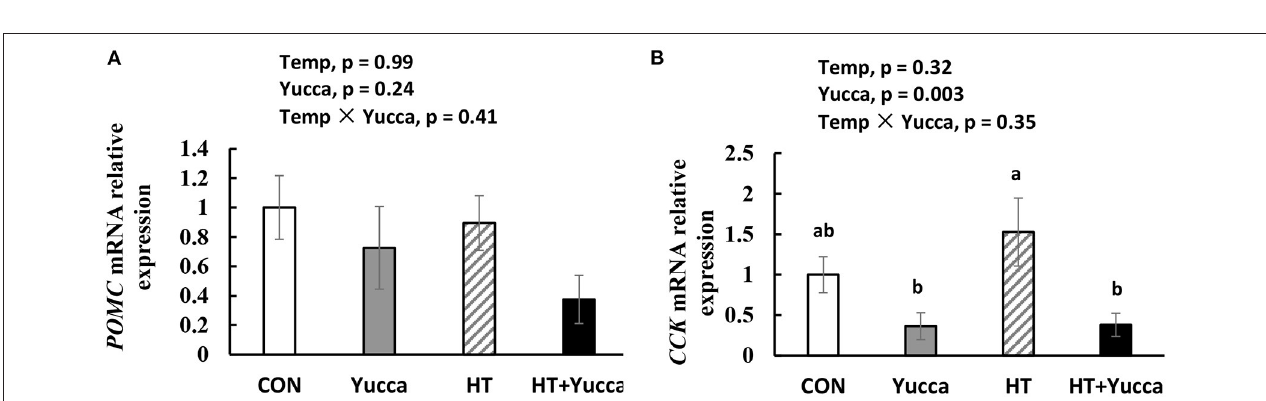
FIGURE 3 | Plasma concentration of cortisol (A) , NPY (B) , CCK (C) , and ghrelin (D) in broilers at 56 days. Broilers, of 28 days of age, were fed a basal diet and exposed to 24 ◦ C (CON) or 34 ◦ C (HT), or a basal diet supplemented with 0.1% yucca and exposed to 24 ◦ C (Yucca) or 34 ◦ C (HT + Yucca) for 4 wks. Values are means ± SE, n = 6. Means without a common letter differ ( P < 0.05). CCK, cholecystokinin; NPY, neuropeptide.